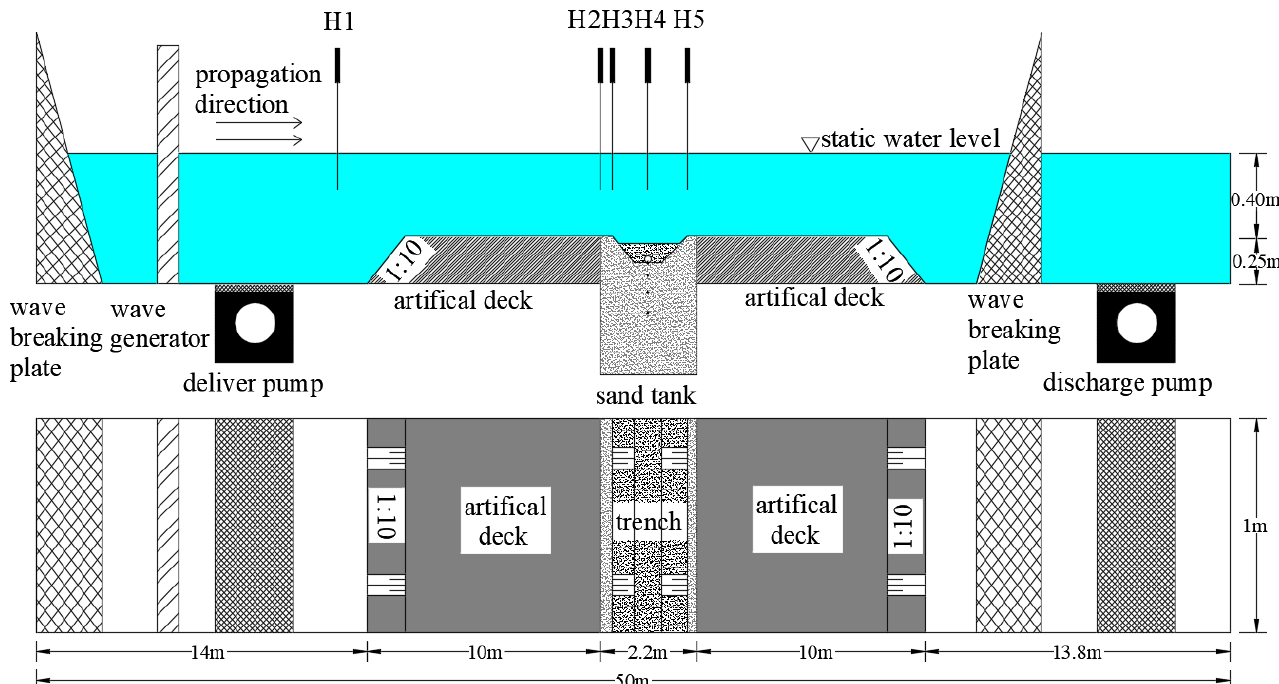
Figure 1. Set-ups of laboratory wave – current flume.